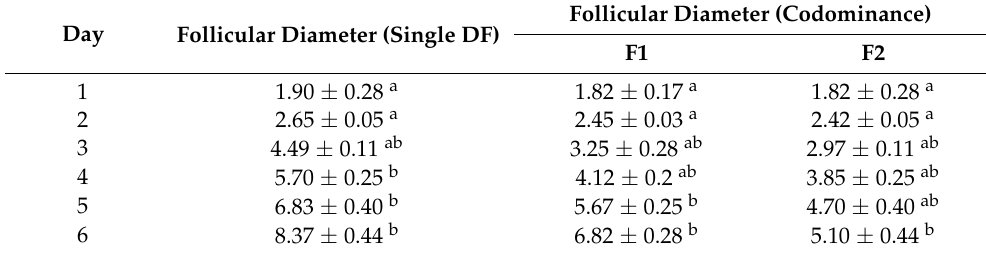
Table 1. Follicle diameter in llamas ( Lama glama ): single dominant follicle vs. codominance during the monitorisation process (Day 1 to Day 6).